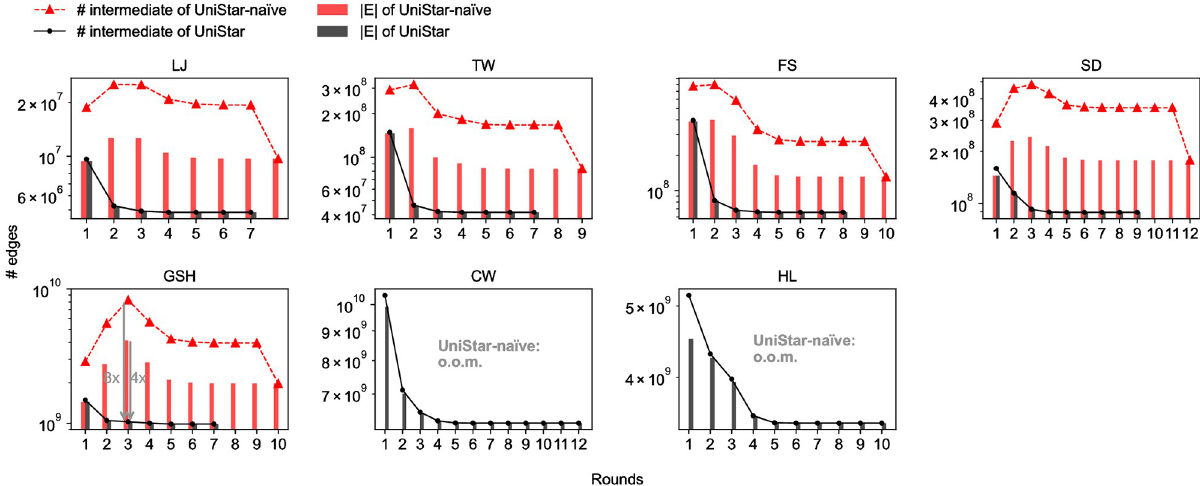
Fig 8. The input and intermediate data sizes of UniStar and UniStar-na ï ve each round. UniStar reduces both sizes by up to 4 × and 8 × , respectively, compared to UniStar-na ï ve.